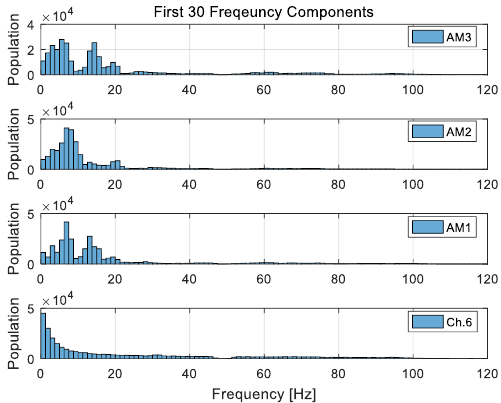
Figure 16. Histogram of first 30 frequencies: